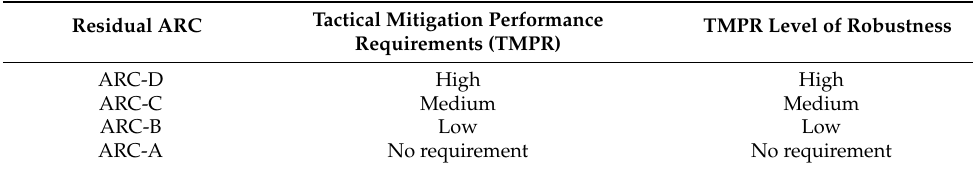
Table 8. Tactical mitigation performance requirement (TMPR) and TMPR level of robustness assign- ment [20].